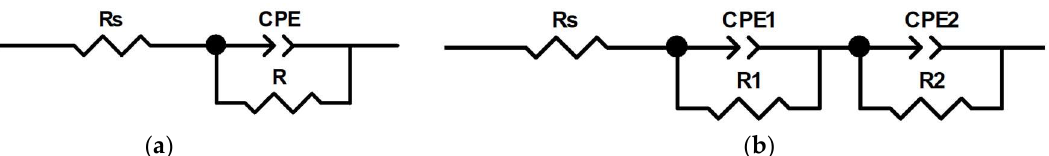
Figure 9. The electrical equivalent circuit was used to model the impedance data of ( a ) untreated titanium substrate and ( b ) PEO-treated titanium.